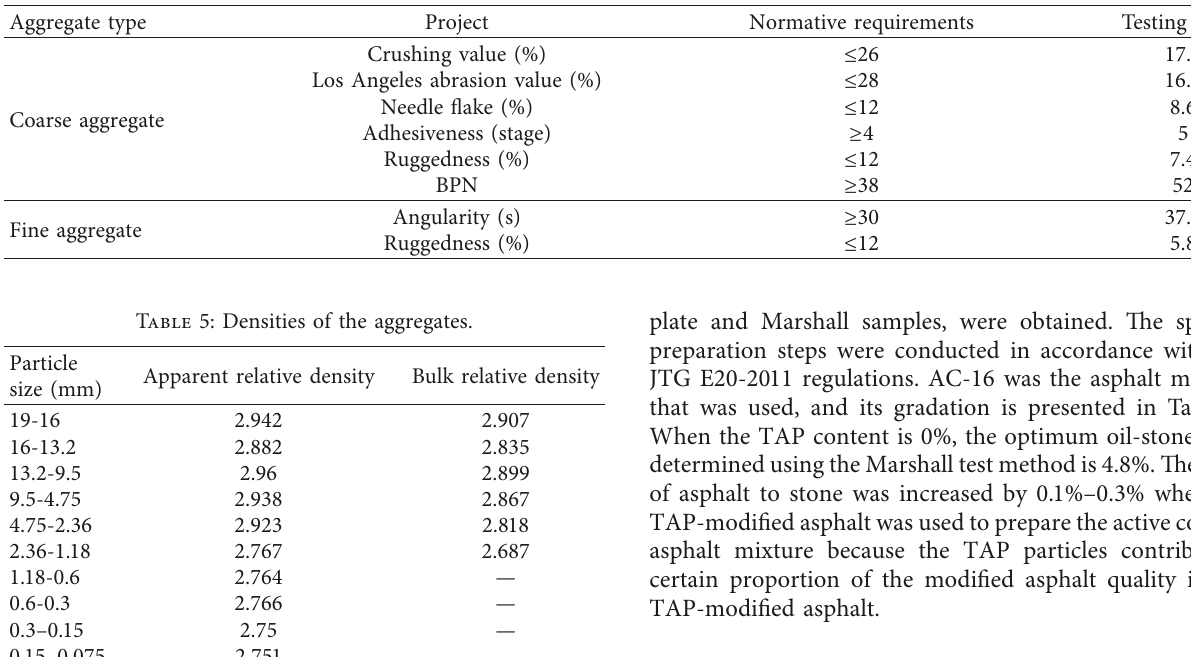
Table 4: Performance parameters of the aggregates.